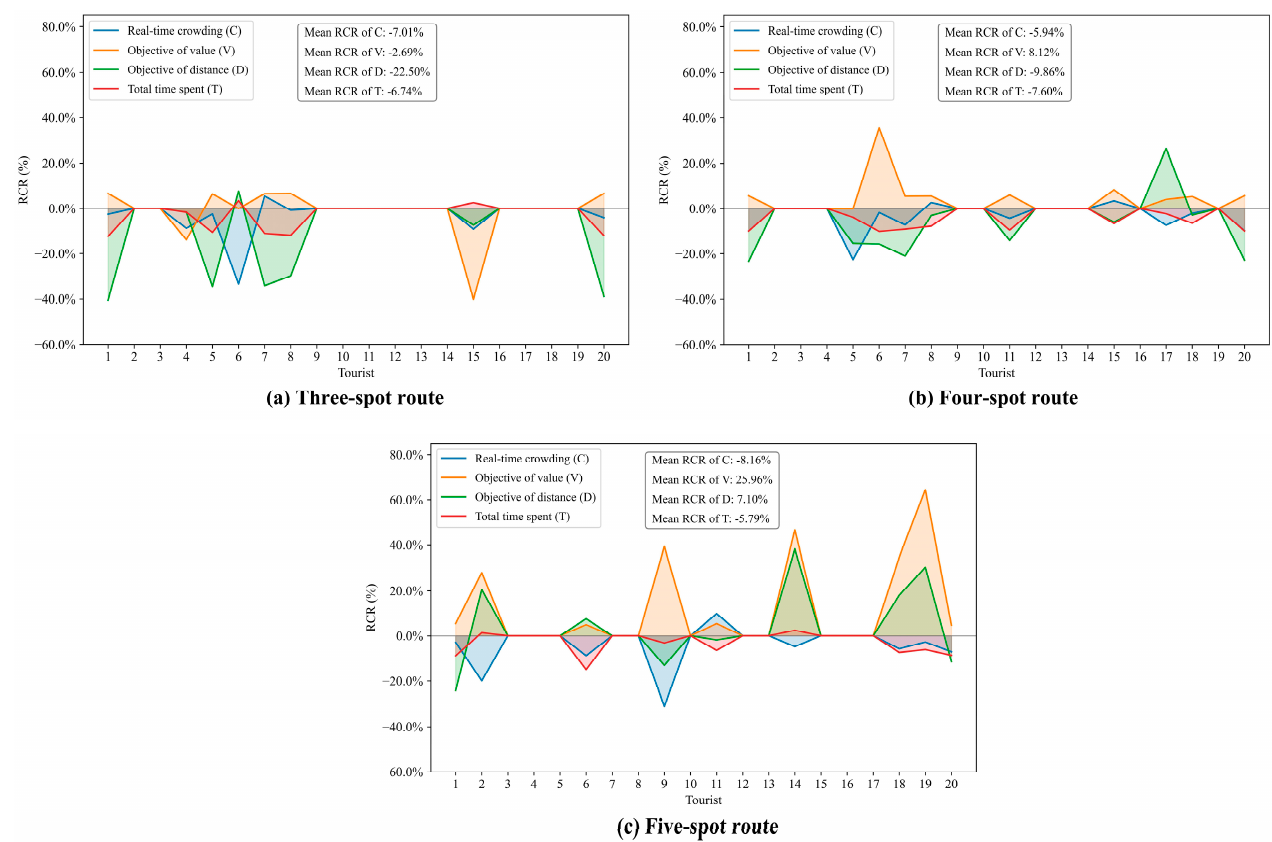
Figure 14. The comparison of objective function values of routes before and after adjustment: ( a ) Three spot route; ( b ) four-spot route; ( c ) five-spot route.